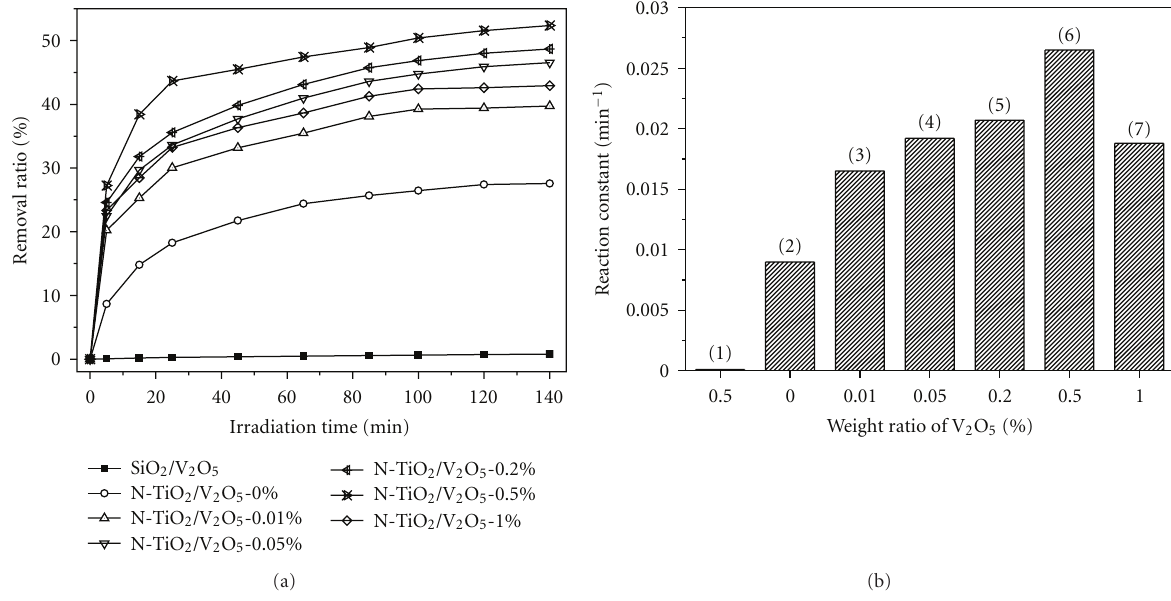
Figure 7: Visible light photocatalytic degradation curves (a) and comparison of the apparent rate constant ( k ) of as-prepared samples (b), (1) SiO 2 /V 2 O 5 sample, (2) N-TiO 2 , (3)–(7) V 2 O 5 cluster modified N-TiO 2